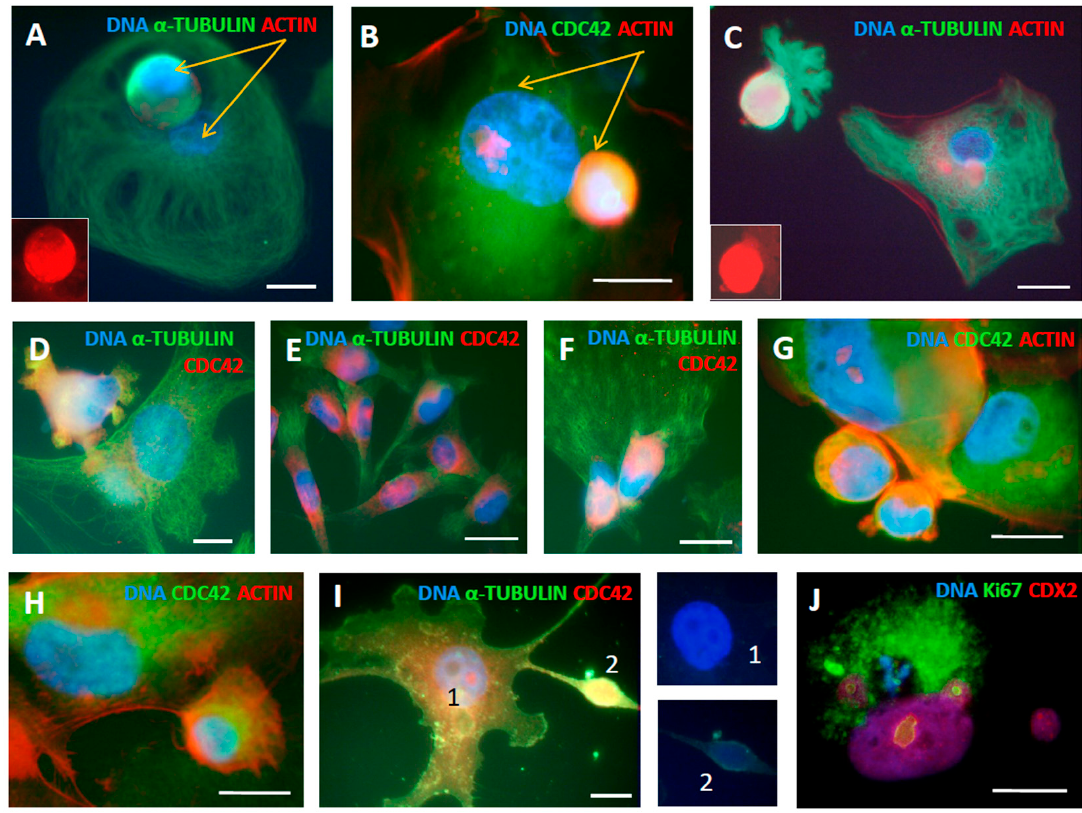
Figure 9. CDC42 kinase acting together with actin and tubulin in late (second–third week) DOX-treated polyploid giant MDA-MB-231 cells participates in collective activities for survival: budding, homing, invasion, and DNA transfer: ( A–D ) giant amoeboid cells on days 13–18 post-DOX treatment budding mobile spore-like sub-cells, which are highly enriched in actin and tubulin and contain CDC42, particularly in the microvilli (in D ); ( A , B ) arrows indicate two type of subnuclei, one in the mobile bud and another immobile remaining at place; ( E ) CDC42 is found in the cytoplasm of NT control cells; ( F ) CDC42-rich small sub-cells located on the surface of the polyploid giant cell; ( G ) CDC42 is found intensely at the periphery of the polyploid giant cell possibly providing homing for their smaller neighbors; ( H ) a giant cell budding a sub-cell; ( I ) the participation of CDC42 in branching the structures filled with diffuse DNA; ( J ) the trophectoderm lineage marker CDX2 weakly positive in a polyploid giant cell nucleus and its two buds, on day 19 after DOX treatment. Bars = 20 µm. Figure 9A,C are reproduced from [4] with an open access CC BY 4.0 license.